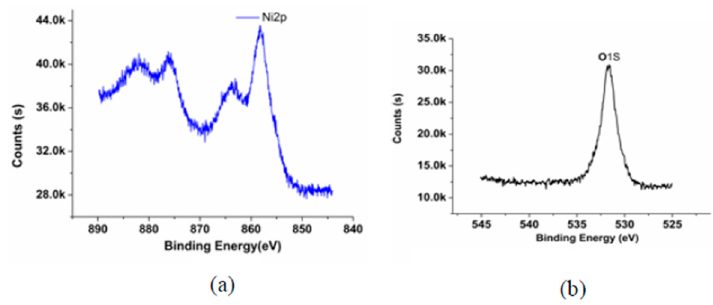
Figure 3. The element content variation curve along with the etching time: ( a ) 200 W; ( b ) 100 W; ( c ) 0 W; ( d ) 200 kHz; ( e ) 120 kHz; ( f ) 80 kHz.